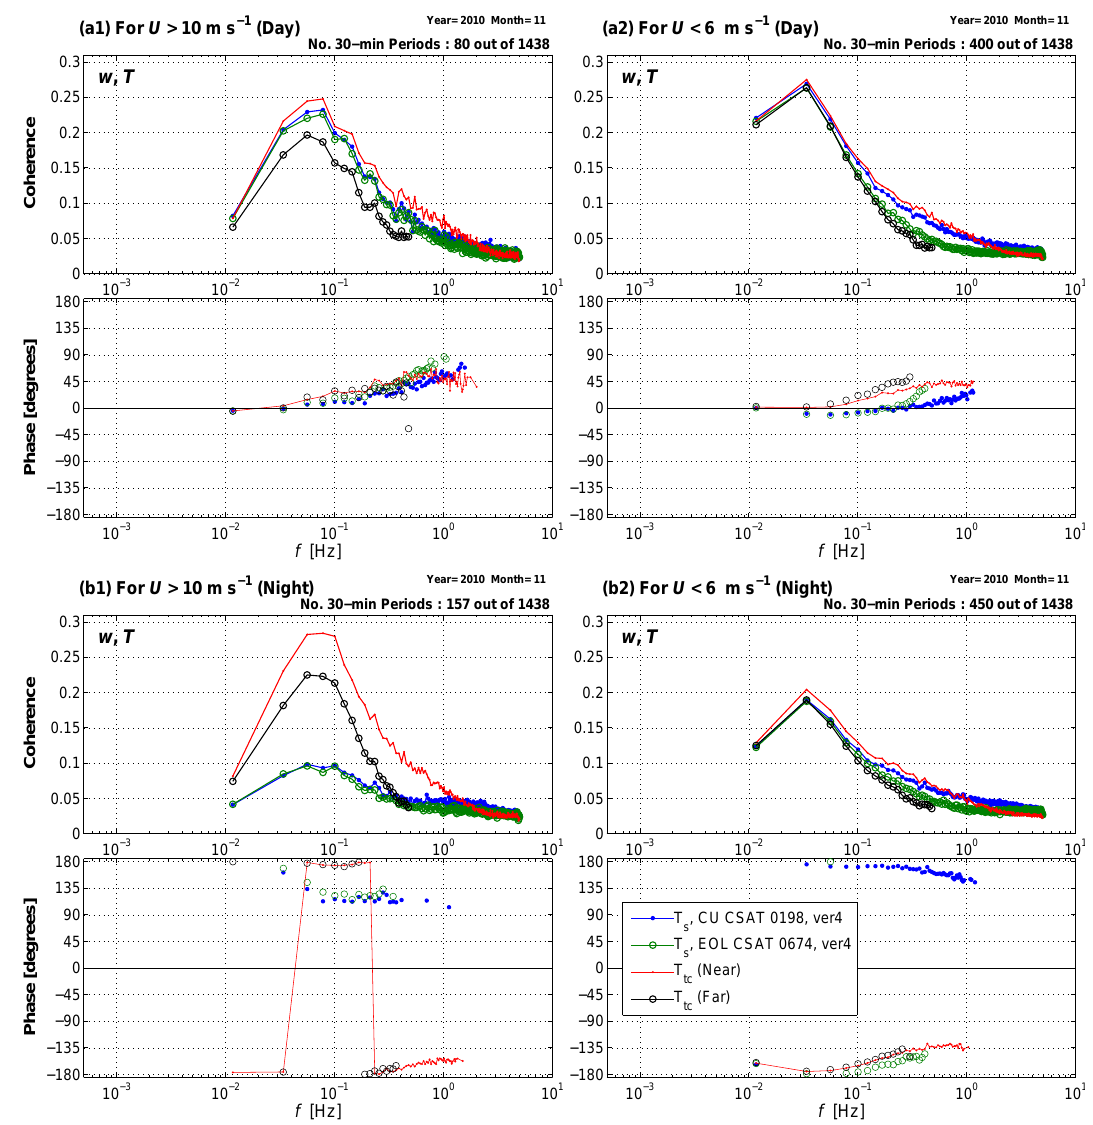
Fig. 5. The spectral coherence (Coh) and phase between the CU CSAT 0198 ver4 vertical wind w and temperature T from different sensors (as described in the legend) versus frequency f . Data are from November 2010 for (a1) day high-winds, (a2) day low-winds, (b1) night high-winds, and (b2) night low-winds where each line represents the average from all 30-min periods that satisfy the criteria listed above the Coh panel. To calculate these statistics, 224 equi-sized ( N =40pts) linear frequency bins were used. The phase is not shown for Coh < 0.05. For clarity, solid lines are not shown for all w , T combinations in the phase